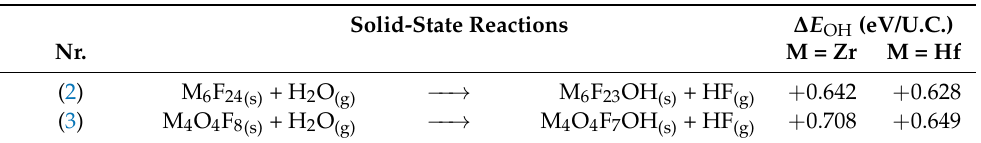
Table 4. Calculated electronic energy contribution ( ∆ E OH ) per unit cell (U.C.) for formations of mono-hydroxylated products according to reactions (2) or (3). Solid-State Reactions ∆ E OH (eV/U.C.)